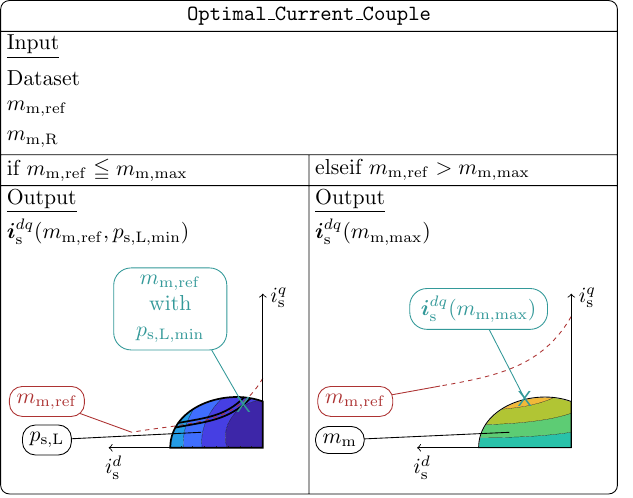
m,ref (dashed line)